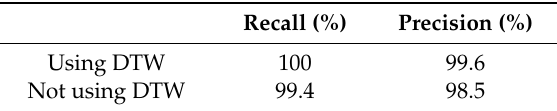
Table 8. Results of linear speed